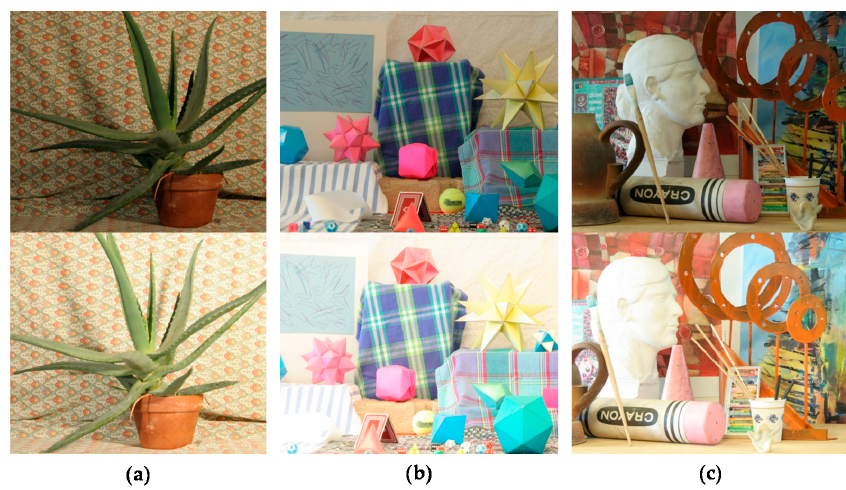
Figure 14. Input image pairs with normal-long exposure from the Middlebury database: ( a ) Aloe ; ( b ) Moebius ; and ( c ) Art . Sensors 2017 , 17 , 1473 12 of 20